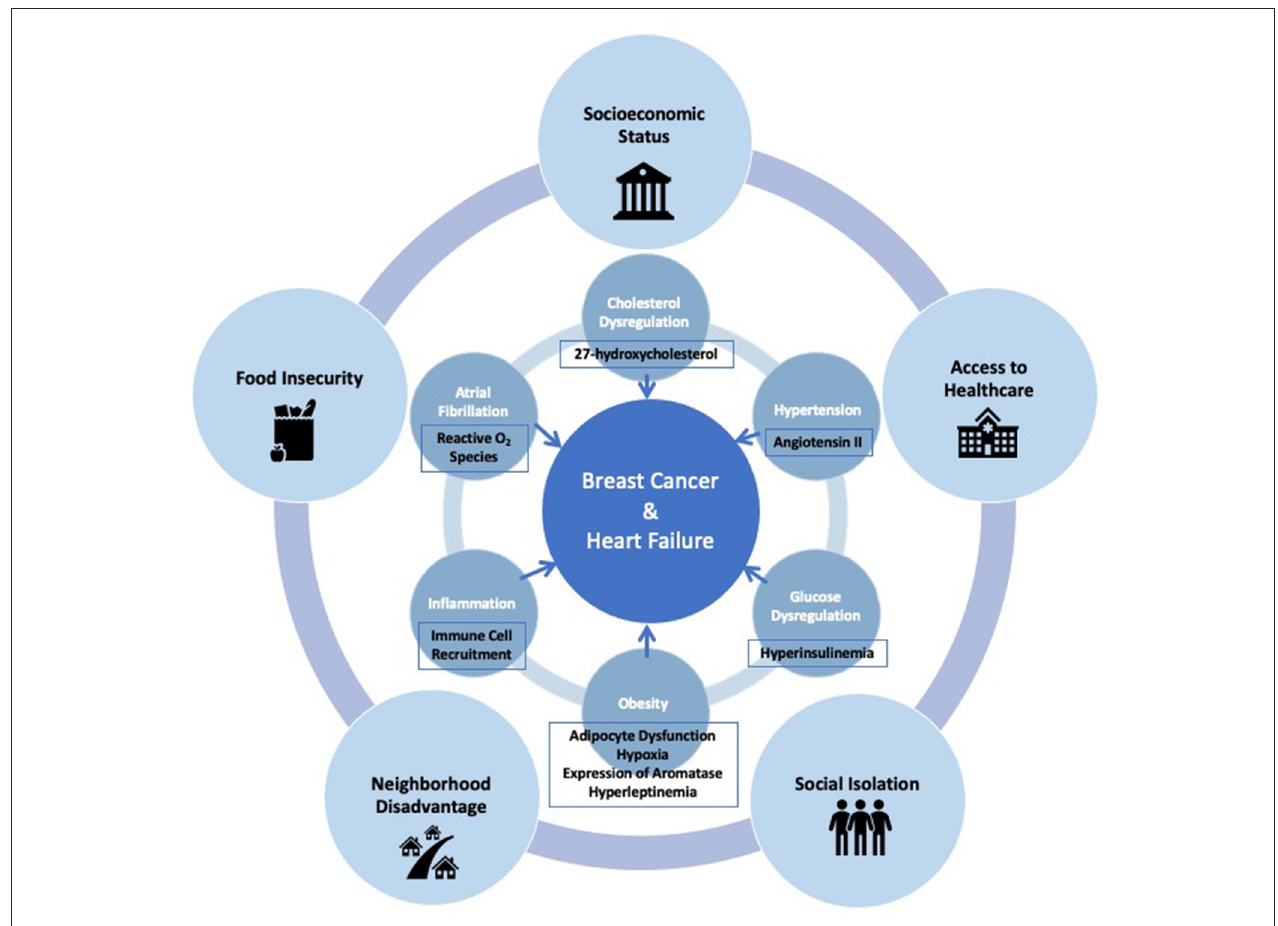
FIGURE 1 | Interconnected social and clinical risk factors, and mechanisms which link the development of breast cancer and heart failure.